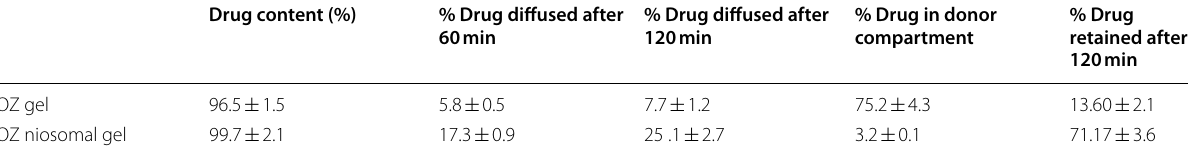
Table 7 Ex vivo permeation studies of OZ (gamma oryzanol) gel and OZ niosomal gel